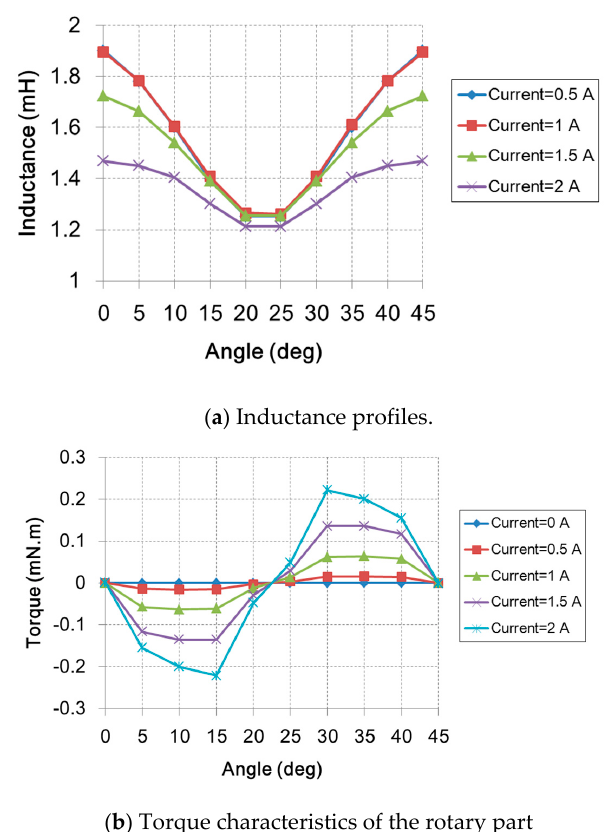
Figure 9. Inductance values and torque outputs under different excitations.